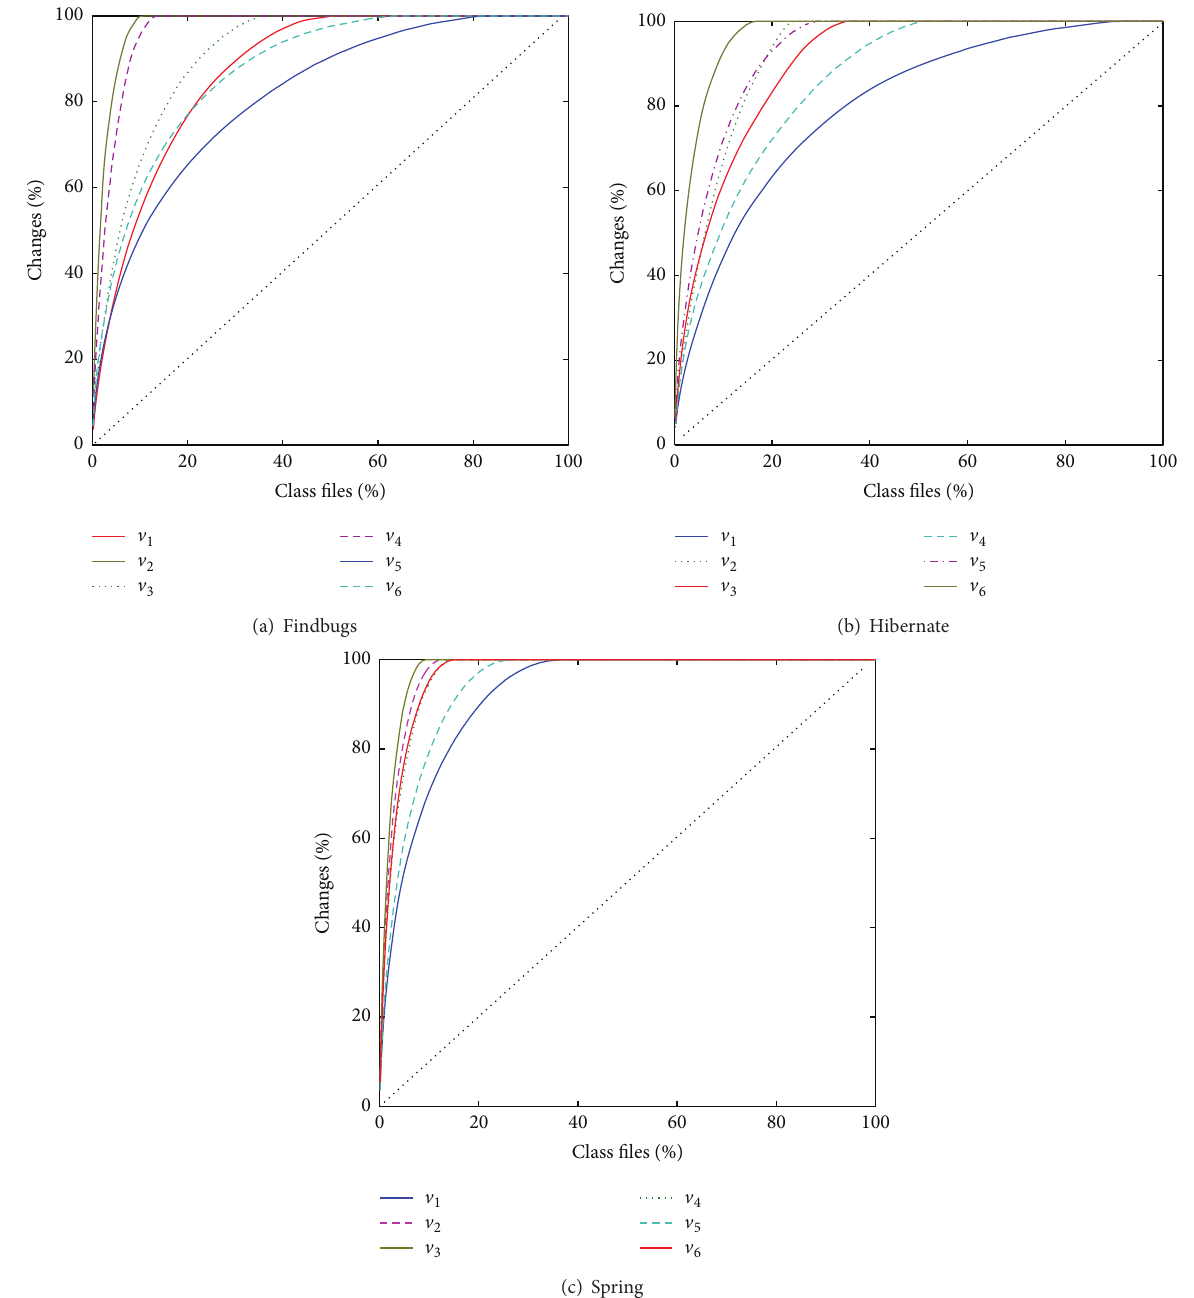
Figure 2: Albert diagram of change